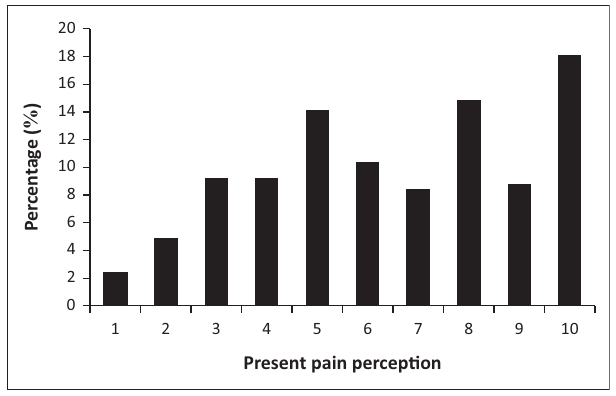
FIGURE 1: Distribution of present pain perception of participants.